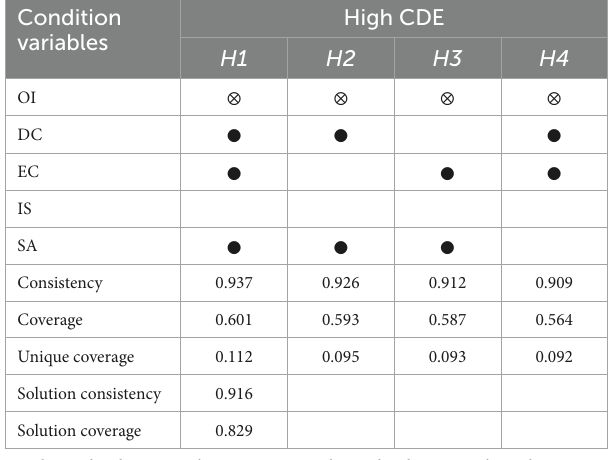
support; SA, strategic alliance.